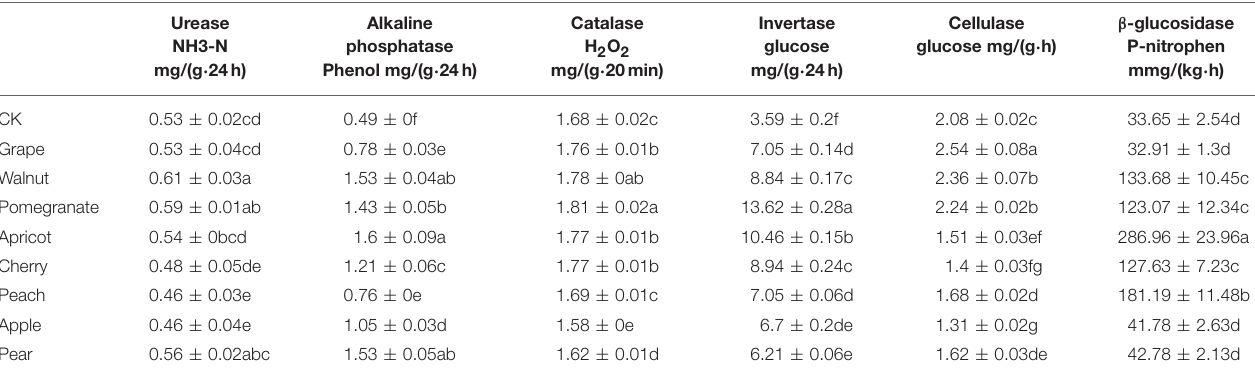
TABLE 2 | Soil enzyme activities of different deciduous fruit trees in northern